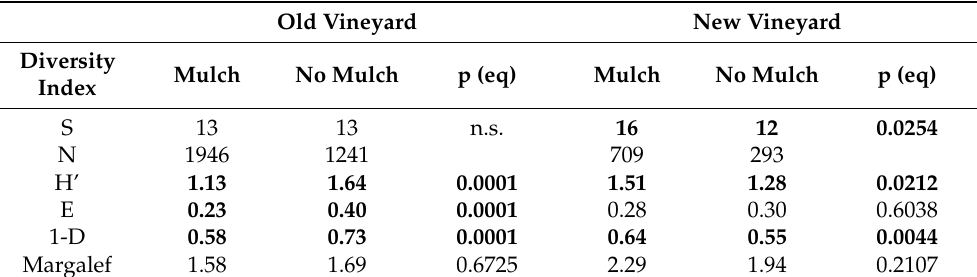
Table 3. Diversity indices of soil arthropods between different inter-row managements (mulch; no mulch plots) in 2014 according to richness (S), total abundance of arthropods (N), Shannon (H’), Evenness (E), Simpson’s (1-D), and Margalef. Significant differences are in bold (Monte Carlo per- mutation test [42]).